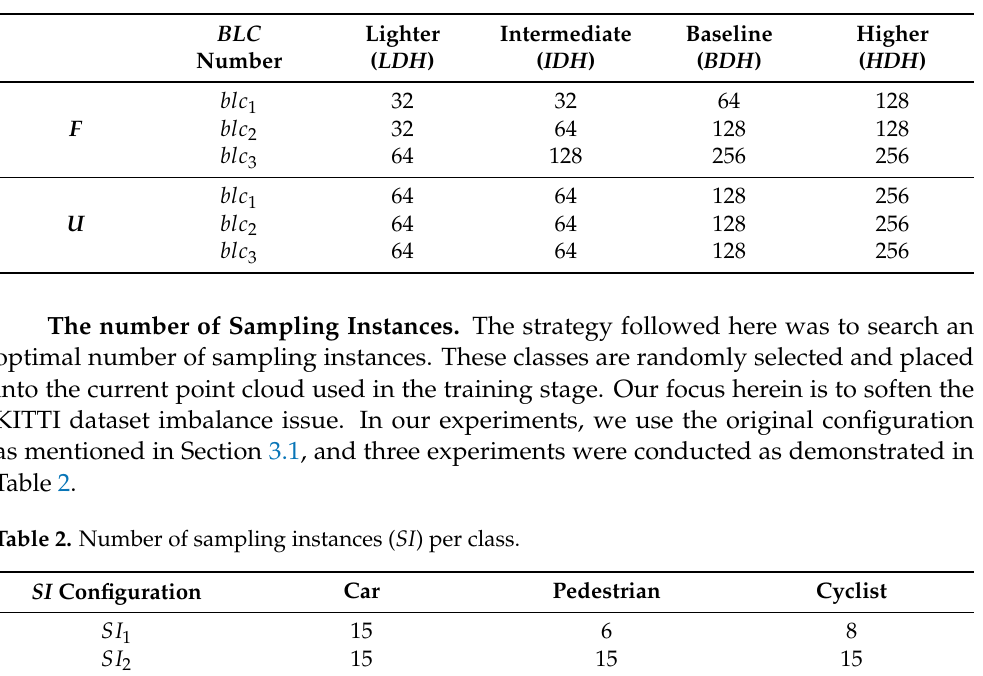
Table 1. Detection Head filters and upsample filters configurations.